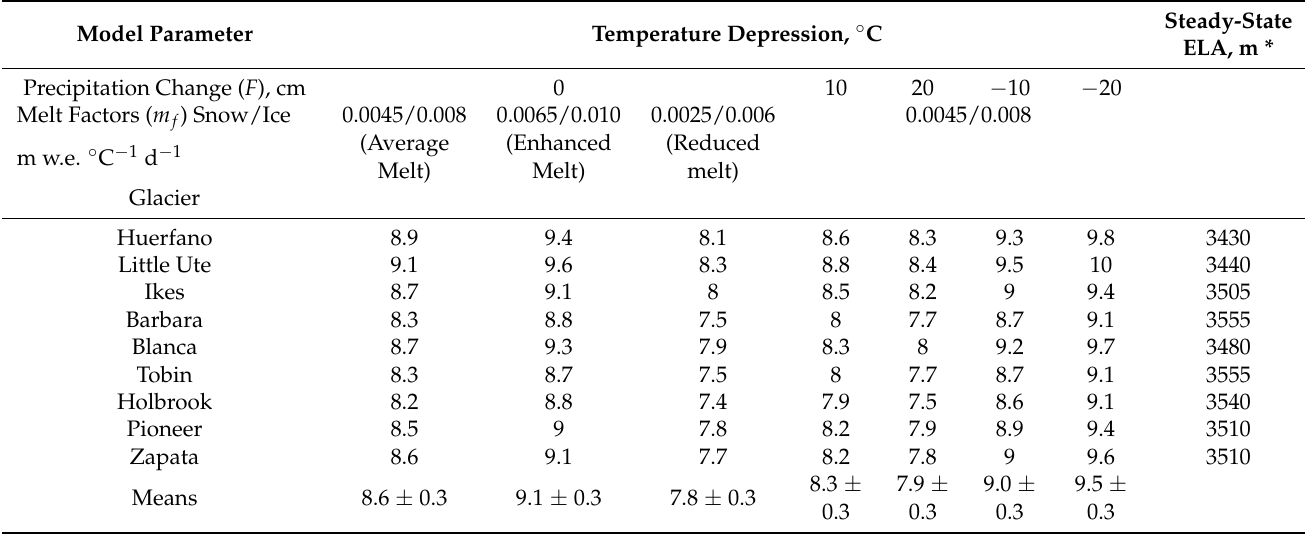
Table 2. Derived temperature depression and ELAs based on steady-state mass balance of paleoglaciers. Temperatures are reported to nearest tenth of a degree. Changes in precipitation are those in mean annual. Model Parameter